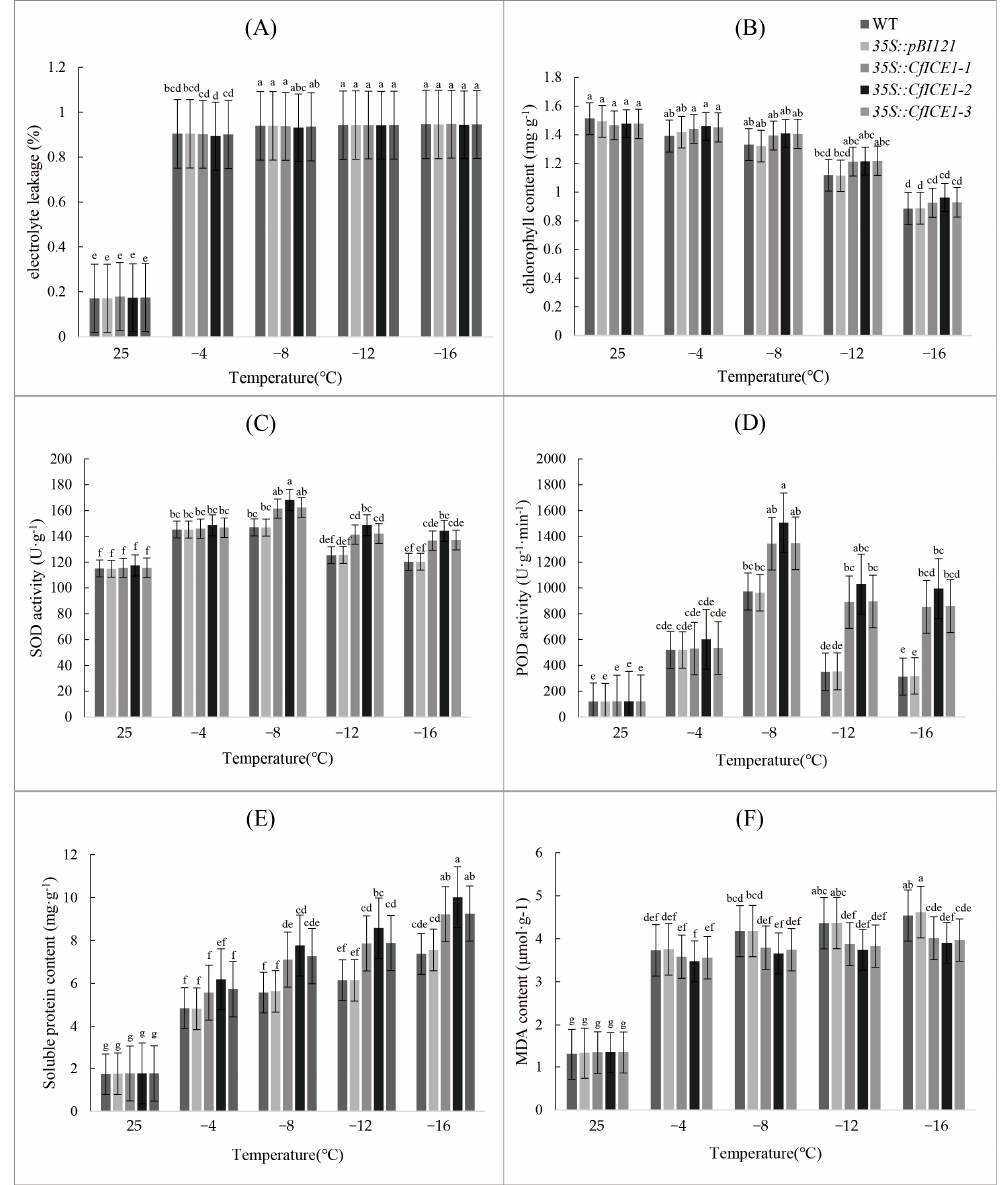
Figure 3. Physiological indices of transgenic, empty vector and wild-type poplar lines under cold stress: ( A ) electrolyte leakage, ( B ) chlorophyll content, ( C ) SOD activity, ( D ) POD activity, ( E ) soluble protein content, ( F ) MDA content. The abscissas of all the above physiological indicators are the treatment temperature. Each bar indicates the average ± SD (n = 3), and lowercase letters above each bar indicate significant differences ( p ≤ 0.05).